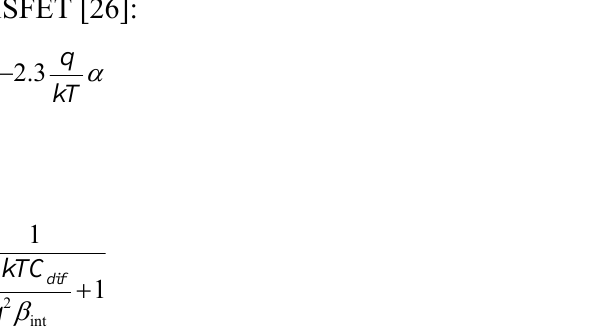
Figure 2. The measurement setup for ZrO